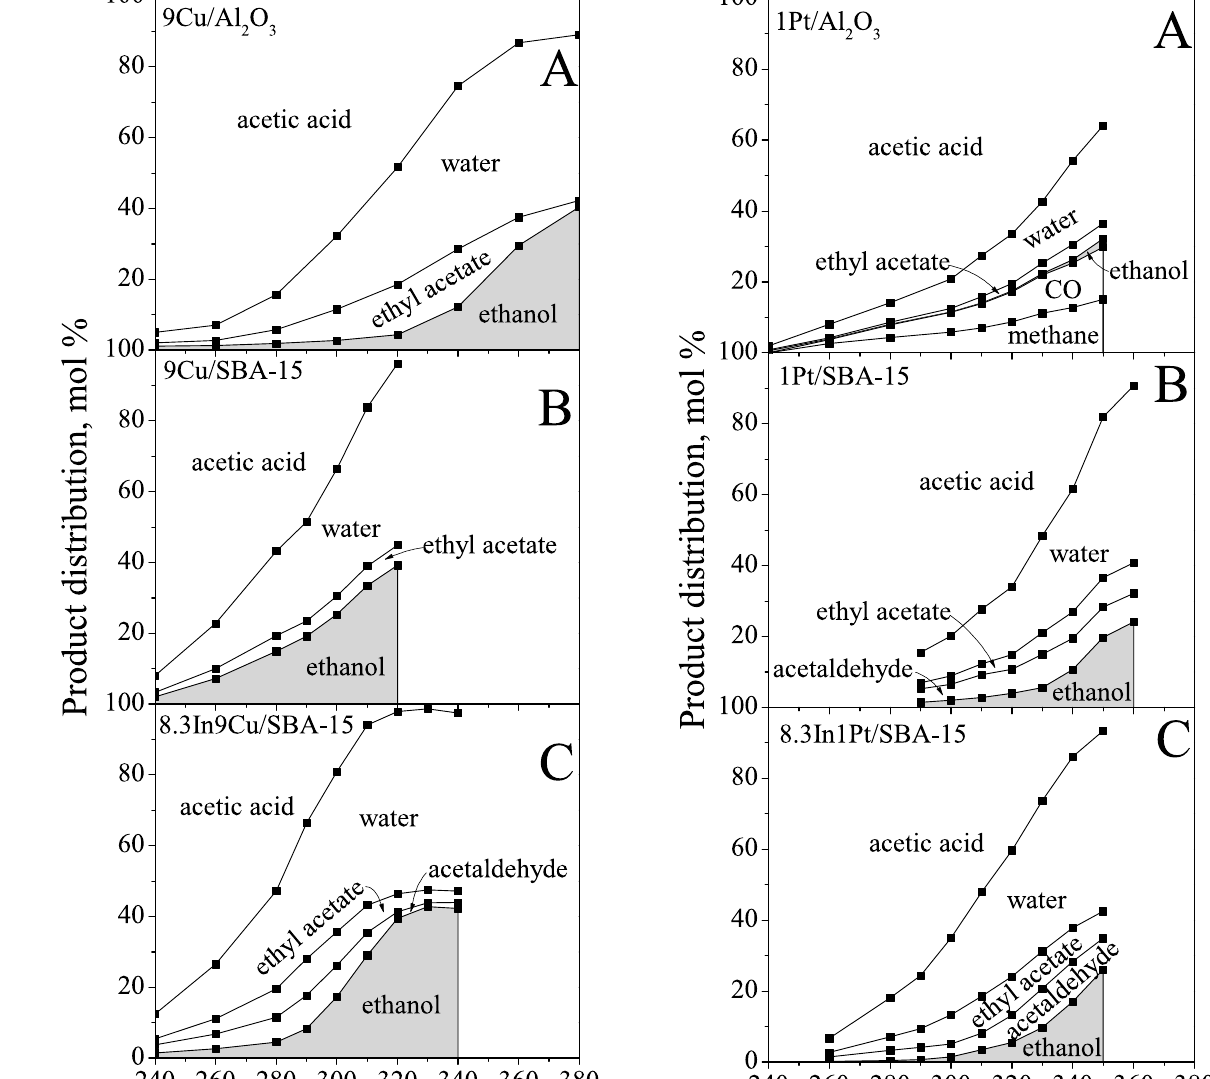
O , (b) Pt/SBA-15 2 3